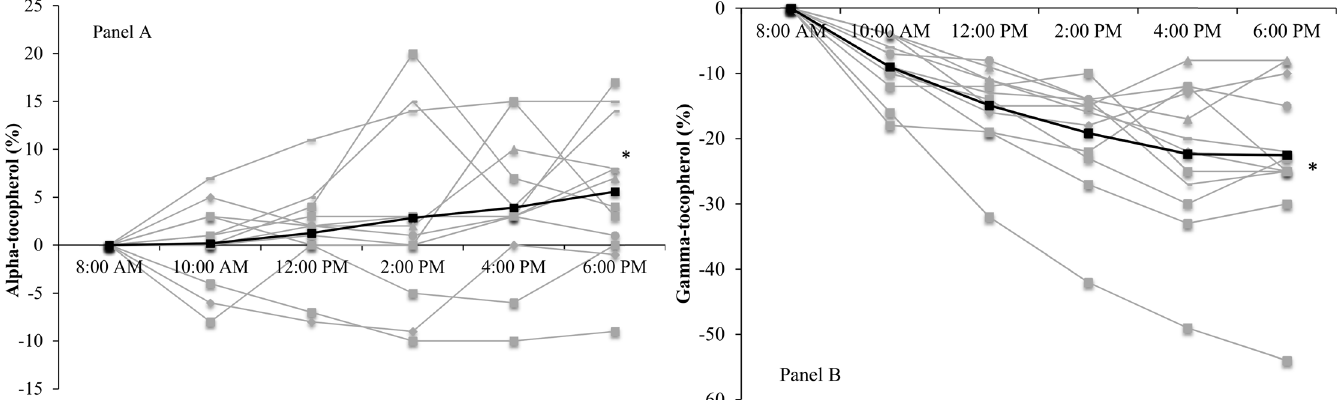
Fig 3. Relative changes (%) from baseline (time point 8:00 AM) for serum α -tocopherol (panel A) and γ -tocopherol (panel B) over the 10-hours (n = 12). Dark black lines denote group average (mean) expressed as percentage change from baseline, with grey lines as individual responses. * Significant effect for serum α -tocopherol (p < 0.001; panel A) and γ -tocopherol (p = 0.002; panel B) over time. P < 0.05.